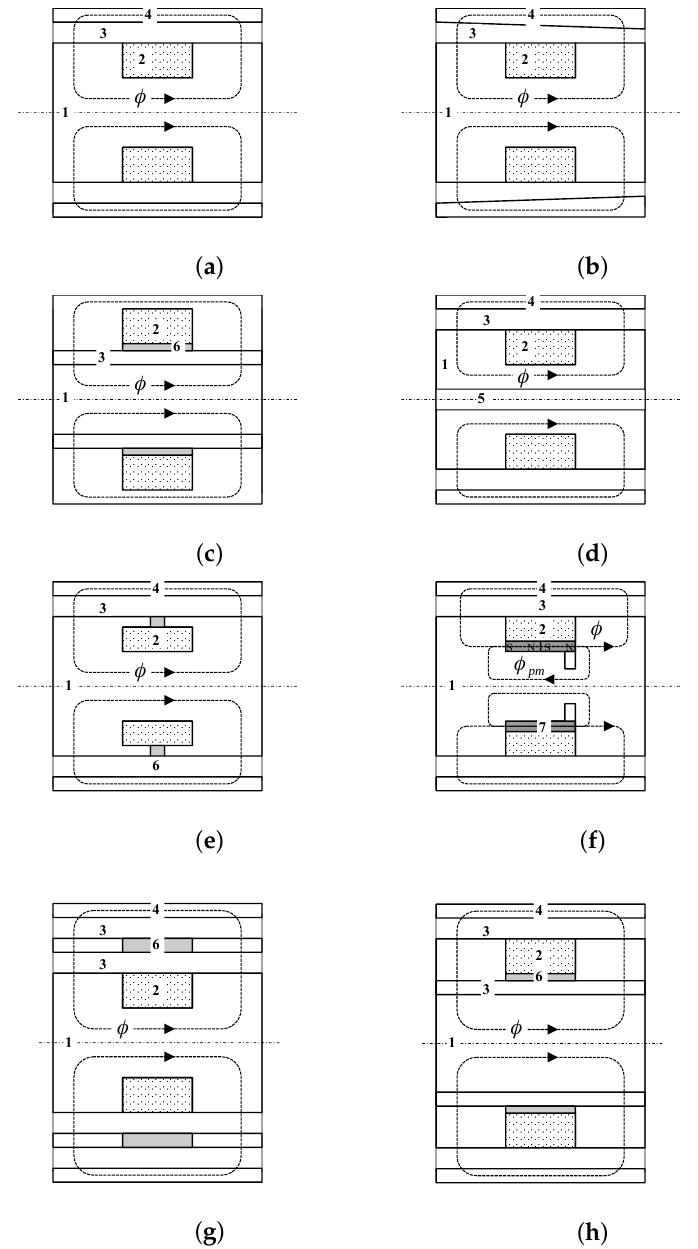
Figure 7. MR valves: configurations, 1—core, 2—coil(s), 3—primary flow path(s), 4—ring, 5—bypass, 6—(non-magnetic) spacer ring, 7—permanent magnet. ( a ) Benchmark valve [24,25]; ( b ) Variable height [69]; ( c ) Annulus location [77]; ( d ) Bypass valve [59,60,78,79]; ( e ) High active area ratio [80]; ( f ) Fail-safe valve [81]; ( g ) Dual annulus (concentric) [66]; ( h ) Dual annulus, adapted from